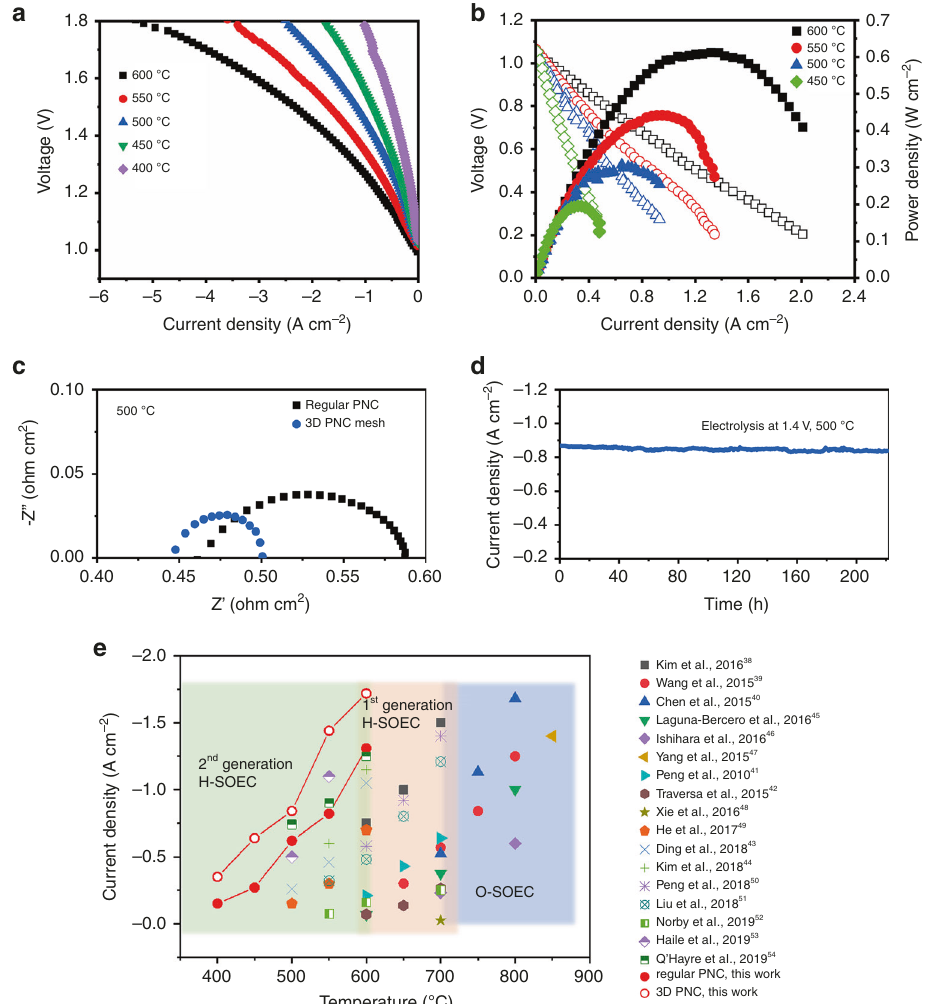
Fig. 5 Enhanced electrochemical performances with nano fi ber-structured electrode. a Current – voltage curves measured in electrolysis mode at various temperatures and dry 10% H 2 and wet air (~10% H 2 O) are used as reactant gas in hydrogen electrode and oxygen electrode, respectively. b Performance in fuel cell mode (pure H 2 is used as fuel). c Comparison of impedance spectra under 1.4 V at 500 °C for cells with regular or 3D PNC electrode. d Durability testing of the cell in electrolysis mode at 500 °C. e Performance comparison of representative SOECs at electrolysis voltage of 1.4 V for oxide-ion conducting SOEC (O-SOEC), fi rst-generation proton conducting SOEC (H-SOEC) operating at high temperatures (600~700°C), second-generation H-SOEC at intermediate temperatures (<600 °C) and high-performing electrolysis cell developed in this convert hydrogen fuel transiently with stable electrode/electrolyte interface observed after testing (Supplementary Note 13 and Supplementary Fig. 23).